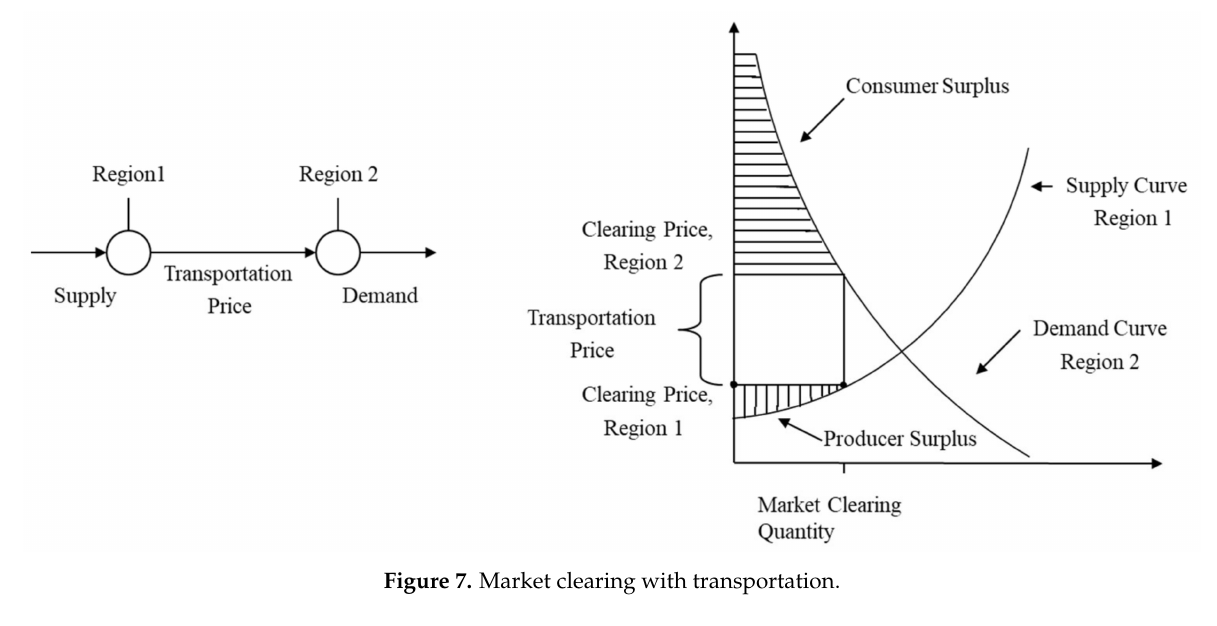
Figure 7. Market clearing with transportation.